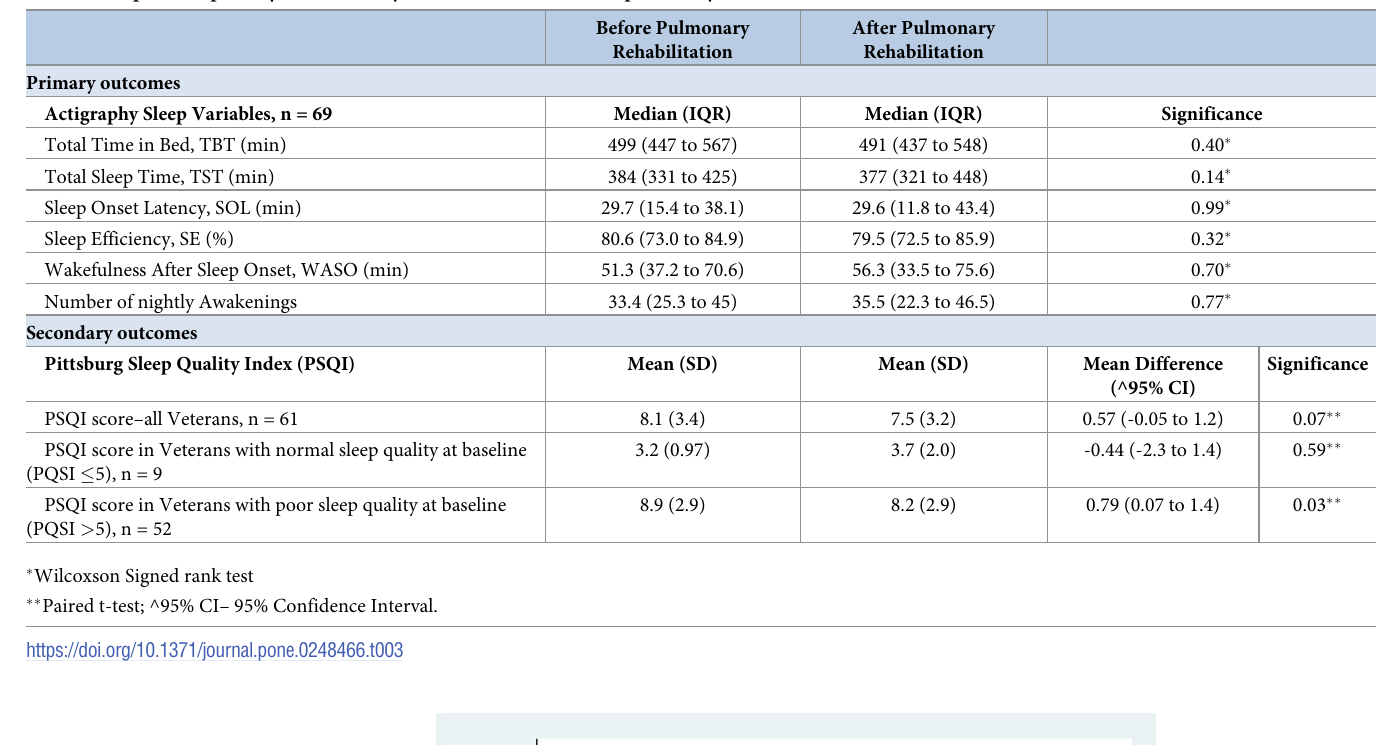
Table 3. Sleep related primary and secondary outcomes after 8-weeks of pulmonary rehabilitation.